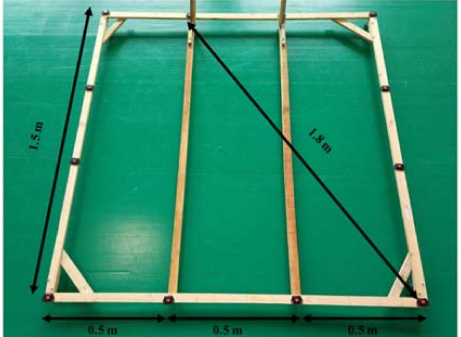
Figure 3. Schematic representation of the custom cart built for tags accommodation and predetermined distances between tags.